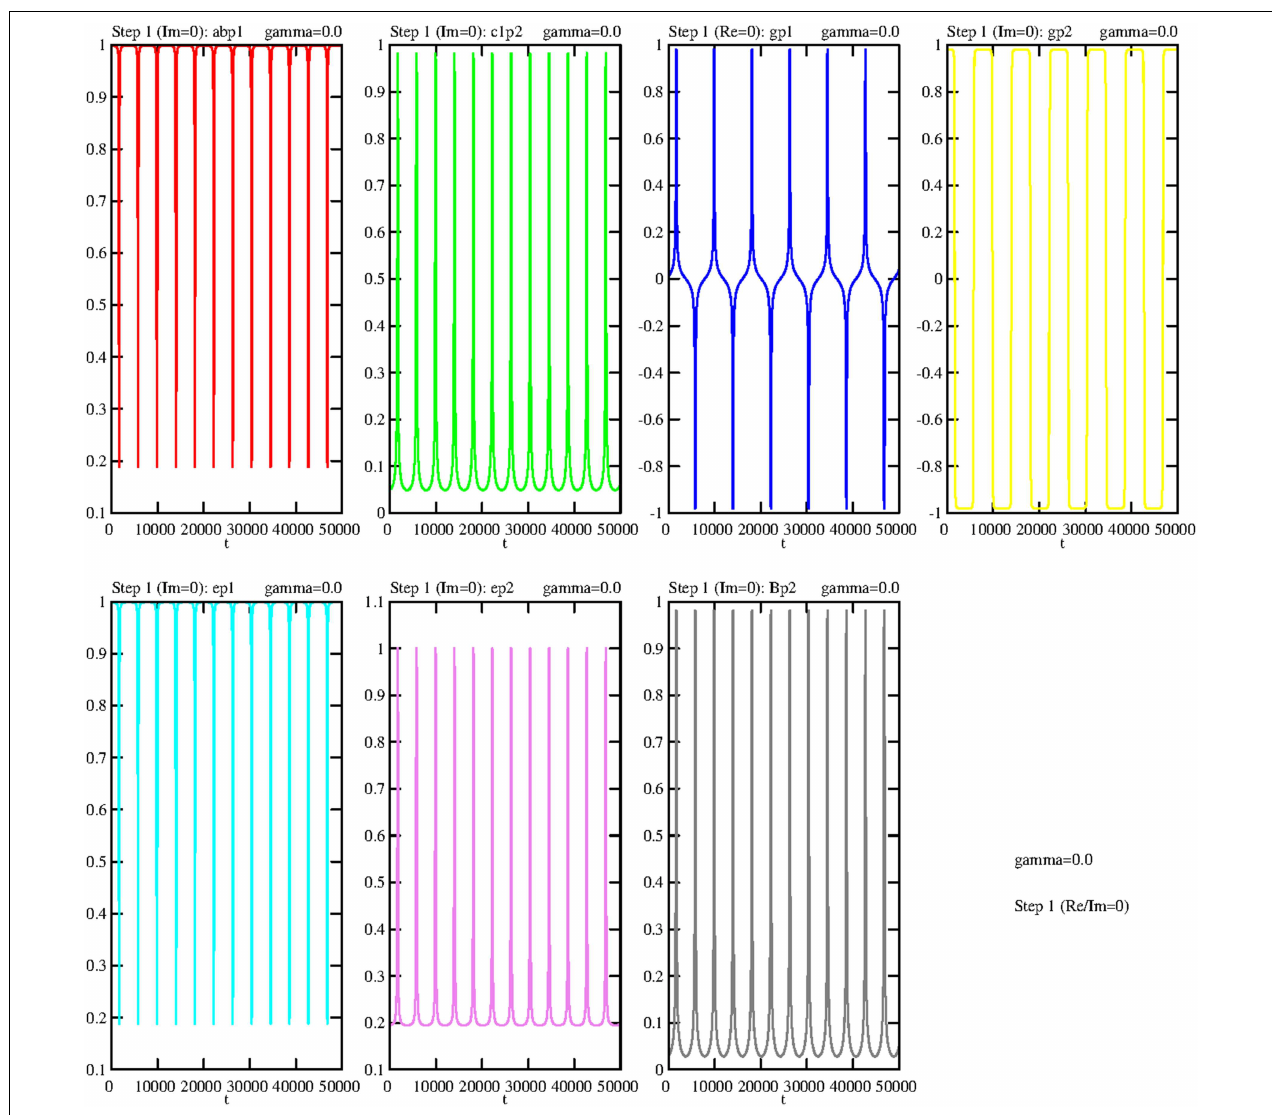
FIGURE 4 | Temporal dependence of the real parts of all variables of step 1, with γ = 0 . The algebraic symbols are: abp 1